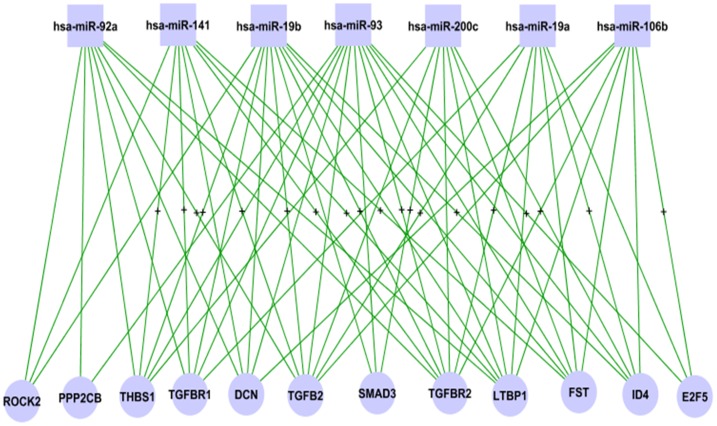
Modular miRNA-mRNA network for TGF-beta signaling pathway.The sub-network was extracted for modules p-module-5-ne(ps). All the connections except for those related to E2F5 are negative. Signal + indicates that at least one miRNA-target-site motif exists in the 3′ UTR sequence of the connected mRNA (gene).